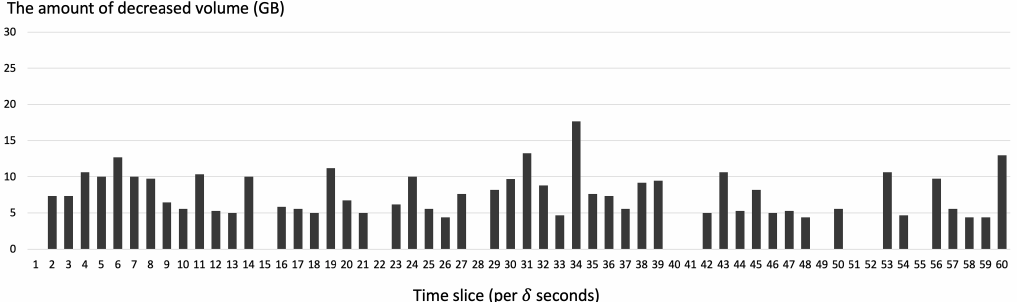
Figure 15. The amount of decreased volume of transferred system images per time slice ( δ seconds) simulated on the server.